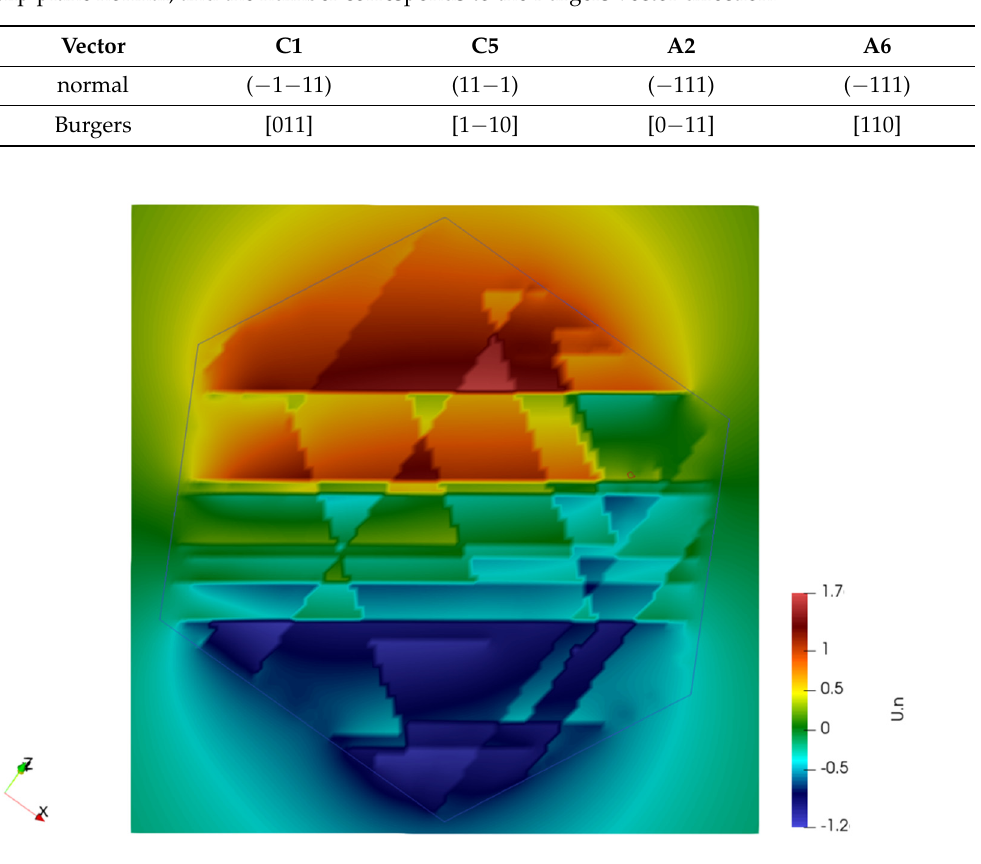
Table 4. Slip system nomenclature following Schmid and Boas notation [26]. The letter indicates the slip plane normal, and the number corresponds to the Burgers vector direction.